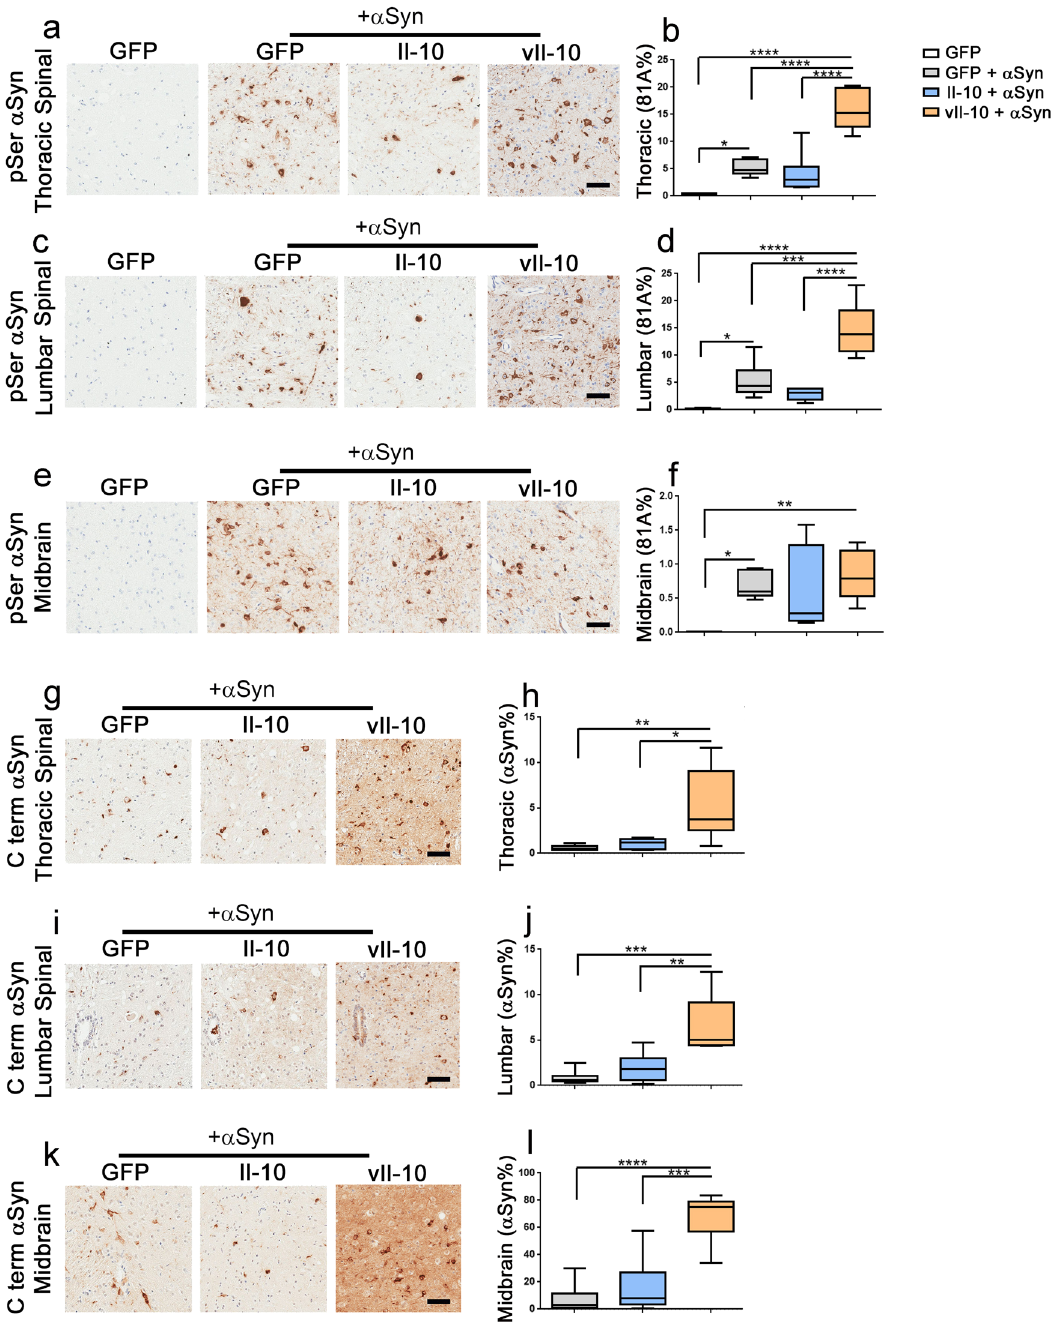
Fig. 5 vIl-10 induces pathological α Syn inclusions and parenchymal α Syn accumulation in α Syn fi bril-seeded hemizygous M83 + / − mice. Neonatal M83 + / − mice were injected with AAV-GFP, Il-10, or vIl-10 and were aged to 2 months when they were injected with α Syn fi brils in the muscle. PBS (vehicle) injection was the control for α Syn fi bril injection and is represented by the immunohistochemistry panel on the far left ( a , c , e ). Representative images and % immunoreactivity burden analysis of 81A antibody (speci fi c to pSer129- α Syn epitope) stained tissue from the thoracic and lumbar segment of the spinal cord ( a – d ) and midbrain ( e , f ). Representative images and % immunoreactivity burden analysis from 15-4E7 antibody (speci fi c to the C terminus of α Syn) stained spinal cord ( g – j ) and midbrain ( k , l ). In the box plot, the whiskers extend from the minimum to maximum values, with the midline representing the median. n = 5 – 7 mice/group; one-way ANOVA; **** P < 0.0001; *** P < 0.001; ** P < 0.01; * P < 0.05. Scale bar, 50 µm. ganglia of vIl-10-expressing α Syn-seeded M83 + / − mice (Fig. 6e, f; vIl-10 increases autophagy dysfunction in α Syn fi bril-seeded M83 + / − mice P < 0.0001), albeit to a lesser extent than observed with Fluoro- Jade C technique. None of the other α Syn-seeded mice We wanted to explore whether the increased parenchymal demonstrated any detectable Fluoro-Jade C or activated caspase accumulation of soluble or cell-free α Syn, as well as intracellular 3 reactivity (Fig. 6d, f). inclusion pathology, could be due to impaired autophagic npj Parkinson’s Disease (2021) 30 Published in partnership with the Parkinson ’ s